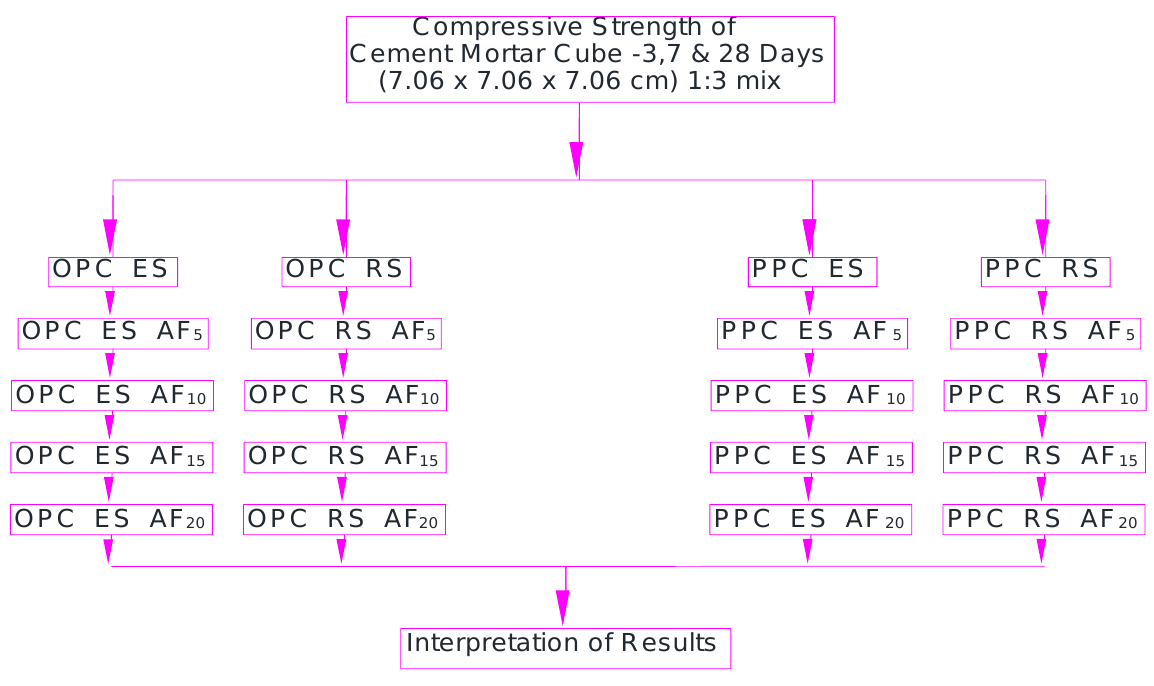
Figure 2. Experimental